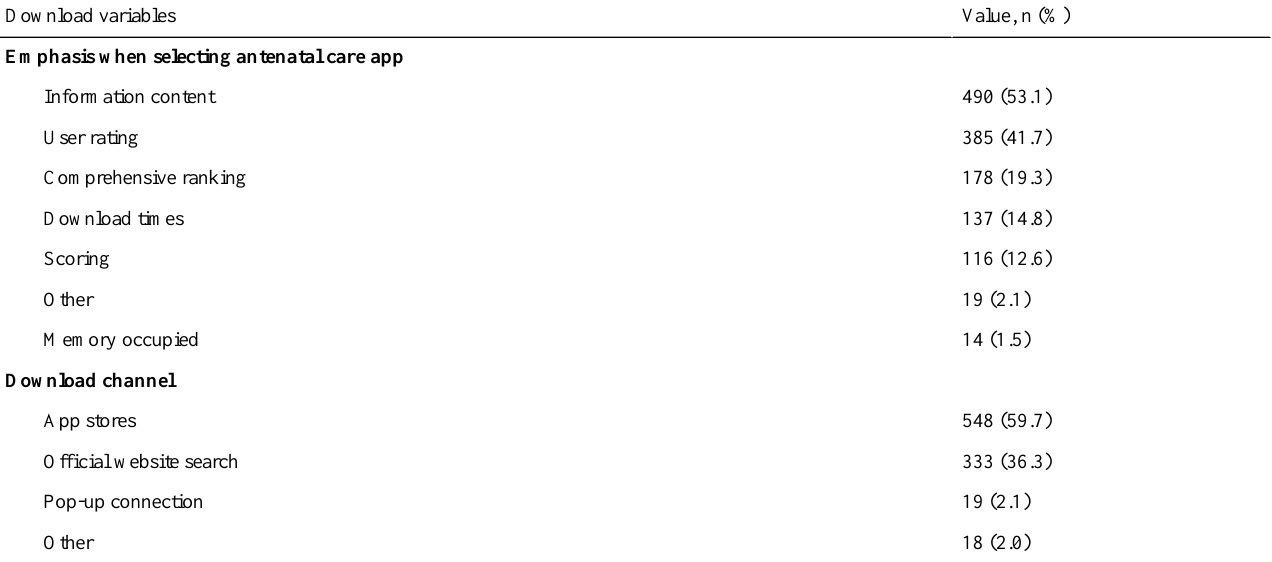
Table 3. Download channels of antenatal care apps.